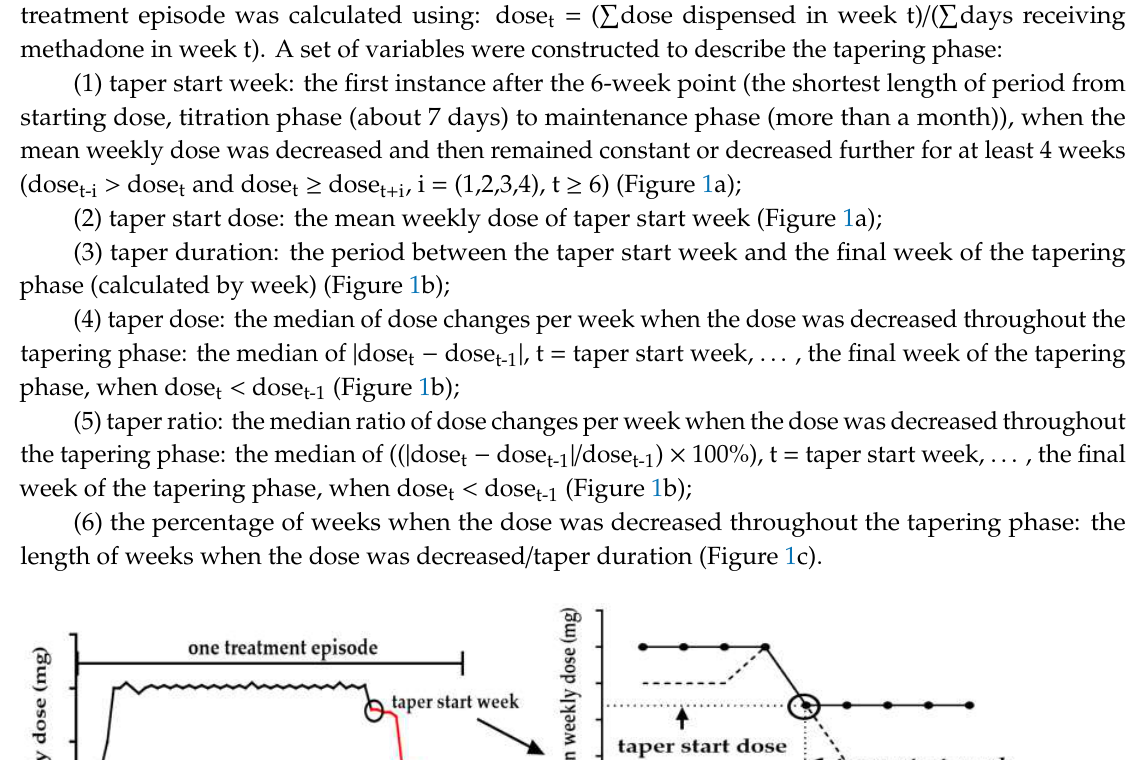
Figure 1. Definition of tapering phase characteristics: ( a ) taper start week and taper start dose; ( b ) taper duration, taper dose and taper ratio; ( c ) the percentage of weeks when the dose was decreased throughout the tapering phase. 2.4. Study Subjects Treatment episodes were selected if they: (1) included a tapering phase; and (2) had urine morphine test records available for the tapering phase. A previous study [18] showed that many treatment episodes entered into the tapering phase but reverted to the prior treatment phase, so we selected treatment episodes where the mean weekly dose was either decreasing during the final 4 weeks of the treatment episode or had decreased to no more than 20 mg/day during the final 4 weeks (dose T-i > dose T or dose T-i ≤ 20 mg (i = 0,1,2,3,4 and T is the last week of the treatment episode)). 2.5. Measures 2.5.1. Dependent Variable